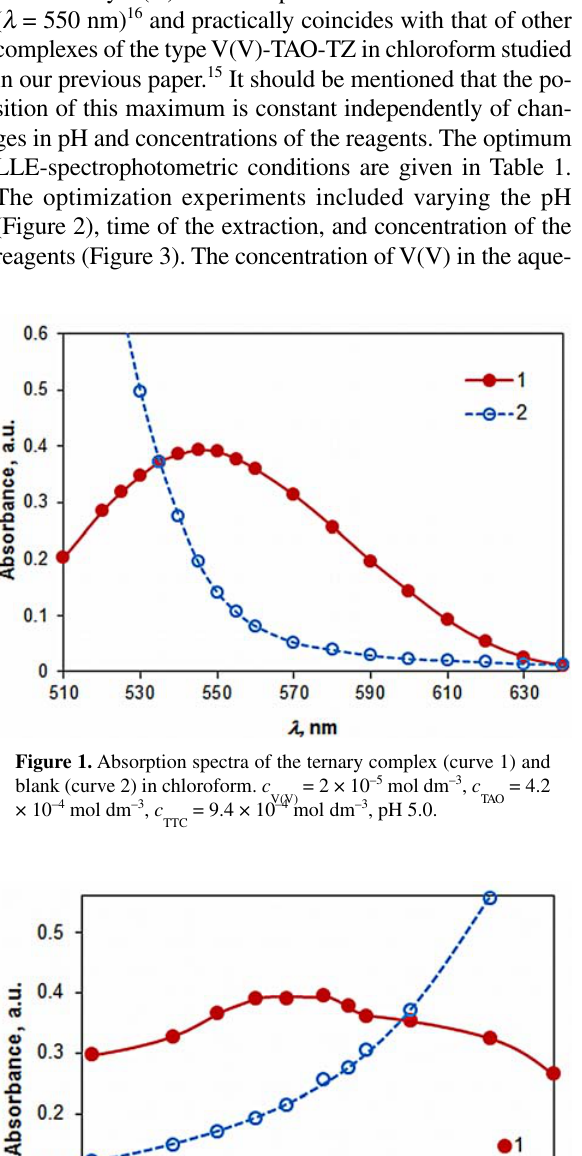
= 2 × 10 -5 mol dm –3 , c = 9.4 × V(V) TTC = 2 × 10 V(V)